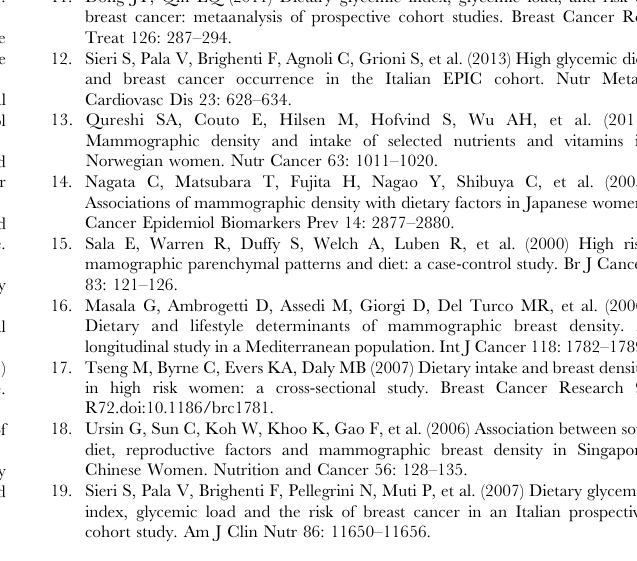
Table S1 Association between energy-adjusted carbo- hydrate (overall and considering simple sugar and starch intakes, separately) and high MBD by menopaus- al status and BMI (1,628 EPIC-Florence